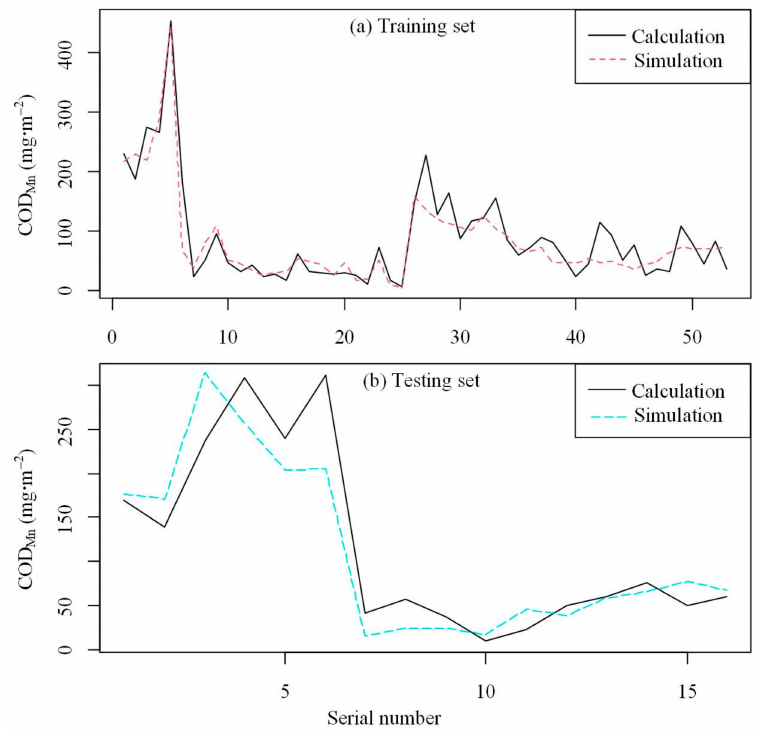
Figure 10. Calculated and simulated runoff COD Mn loads of paddy fields based on SVM. Daily rainfall data can be acquired from rainfall stations in the Taihu Lake